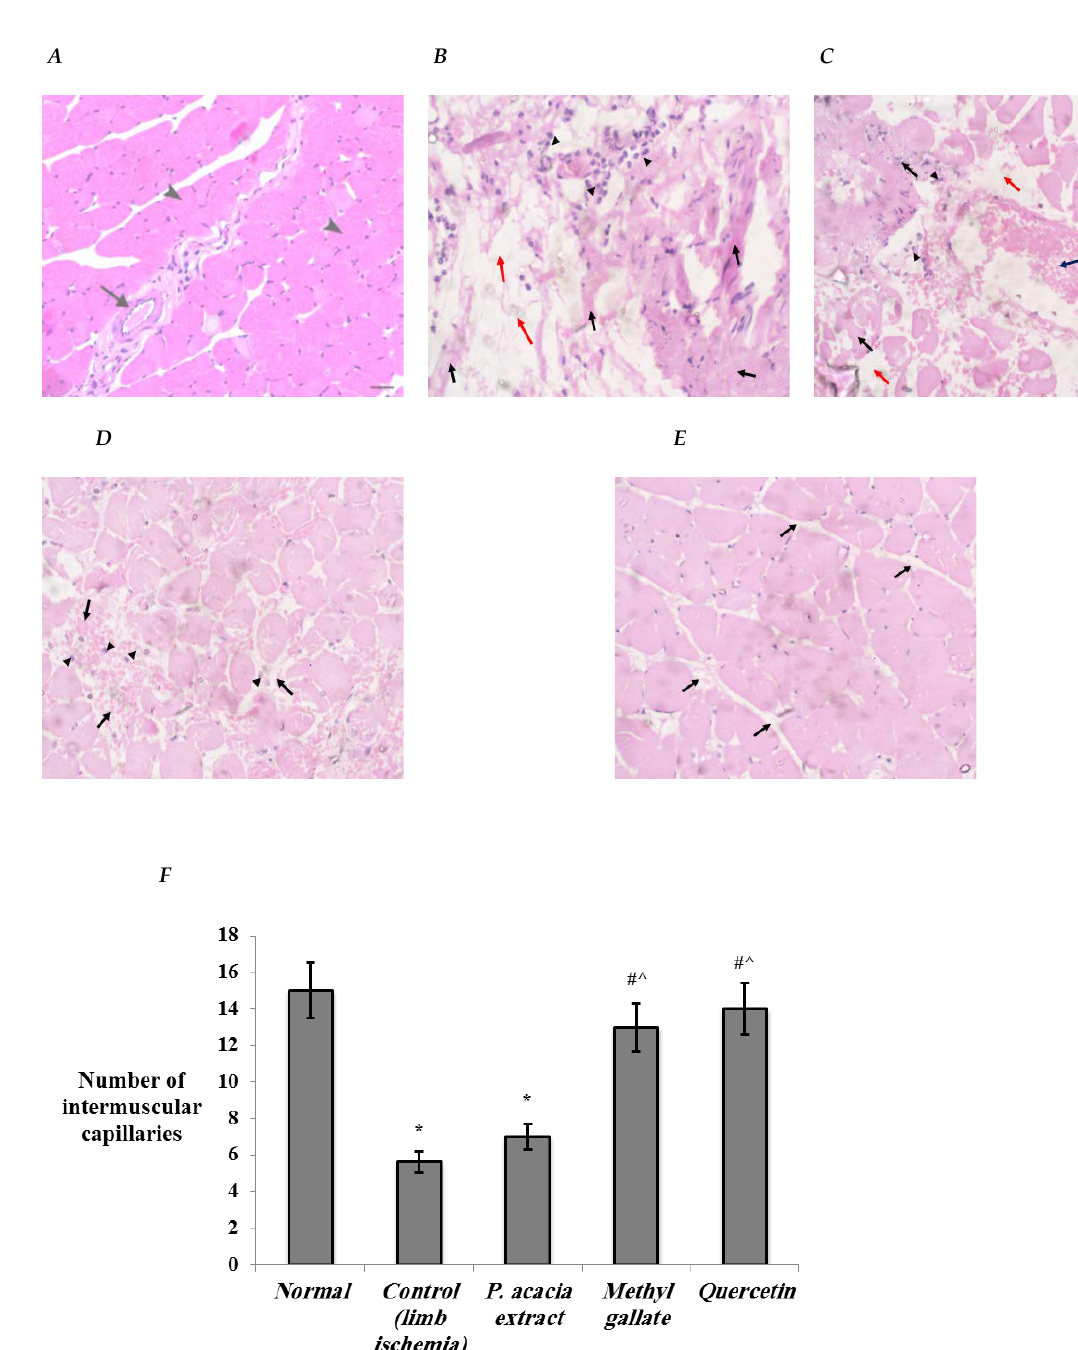
Figure 4. Histopathological investigation of the effects of the P. acacia extract and its isolated compounds (methyl gallate and quercetin) on the gastrocnemius muscle in the experimental rats. ( A ) normal group, ( B ) hind limb ischemia control group, ( C ) P. acacia extract-treated group, ( D ) methyl gallate-treated group, and ( E ) quercetin-treated group. ( F ) Bar charts representing the count of intermuscular capillaries. Data are expressed as the mean ± SD. Data were analyzed using one-way ANOVA followed by Bonferroni’s post hoc test. * Significantly different compared to the normal group, # significantly different compared to the hind limb ischemia control group, ˆ significantly different compared to the group treated with the P. acacia extract. Values were considered significantly different at p <